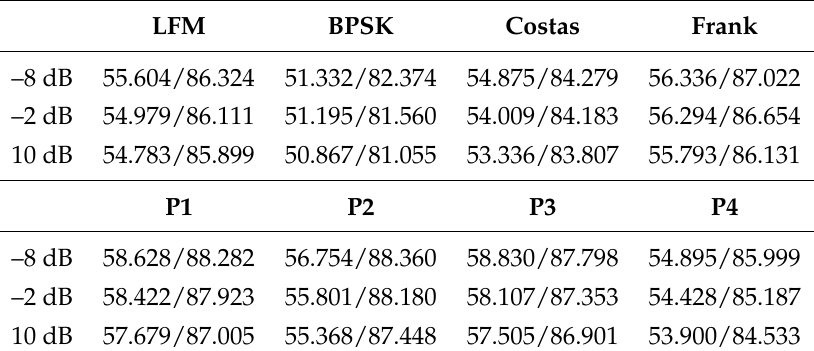
Table 5. Computational complexity test (This paper/Lundén, Unit: